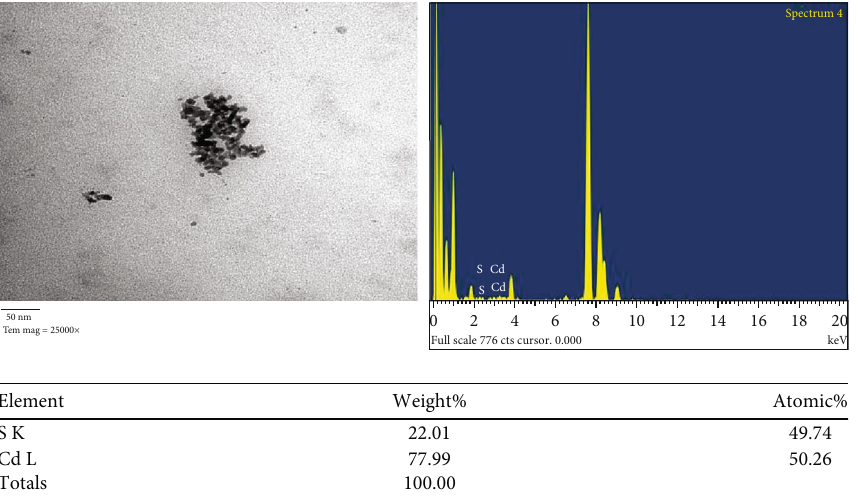
Figure 5: Transmission electron microscopy of the cadmium sul fi de nanoparticles biosynthesized by Aspergillus niger (RCMB 002002).